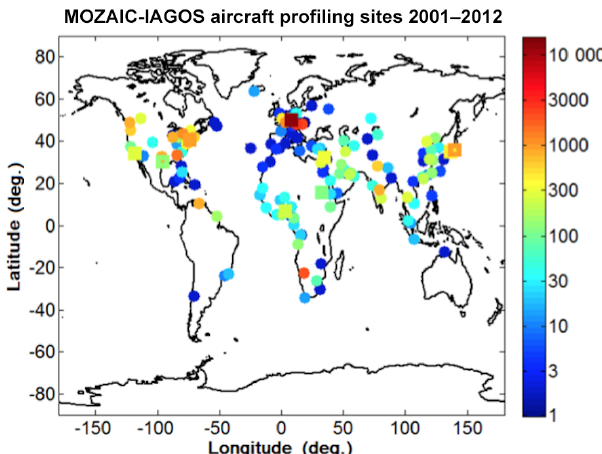
Figure 1. Airports visited by MOZAIC-IAGOS aircraft from 2001 to 2012. The color bar indicates the number of profiles available from each airport. The squares show the locations of the selected airports used for the validation in this